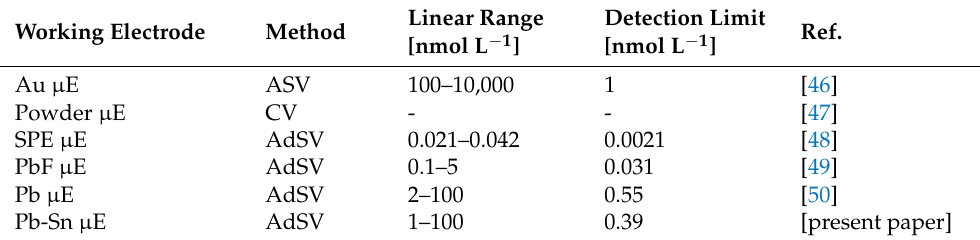
Table 2. Summary of analytical features of procedures of uranium determination using various microelectrodes by means of stripping